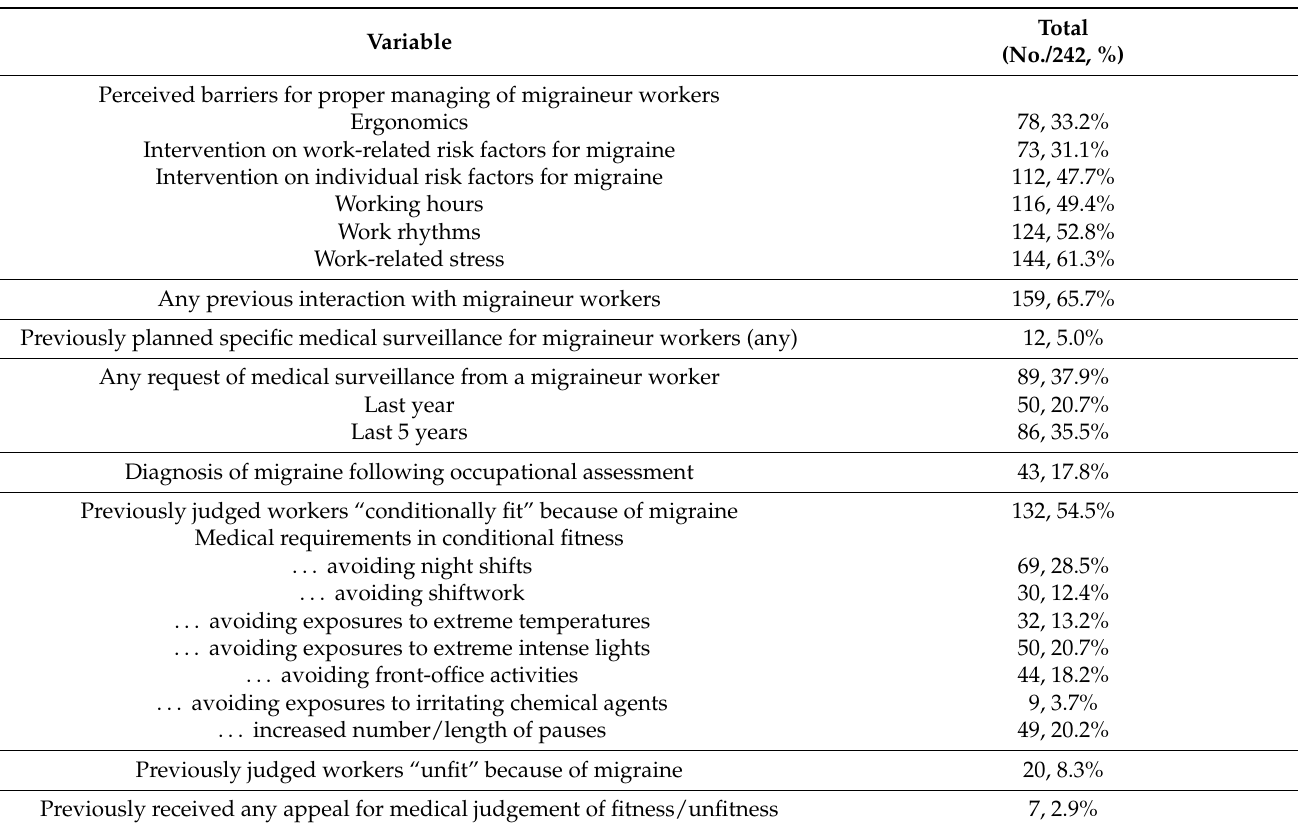
Table 3. Attitudes on the management of migraine in the workplaces from 242 Italian